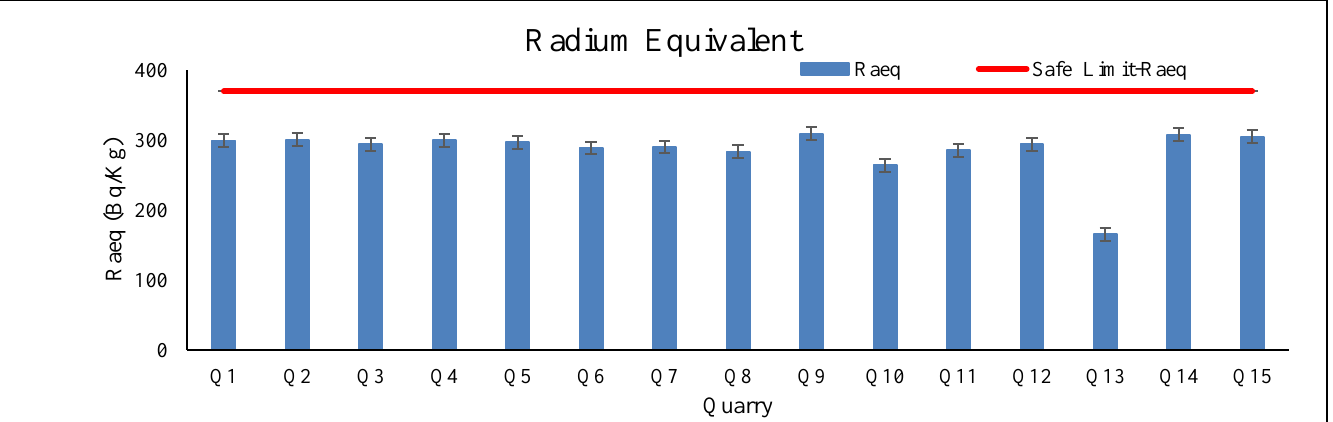
Figure 2: Radium Equivalent of the Collected Rock Samples from Kericho County Quarries. Source: Authors,